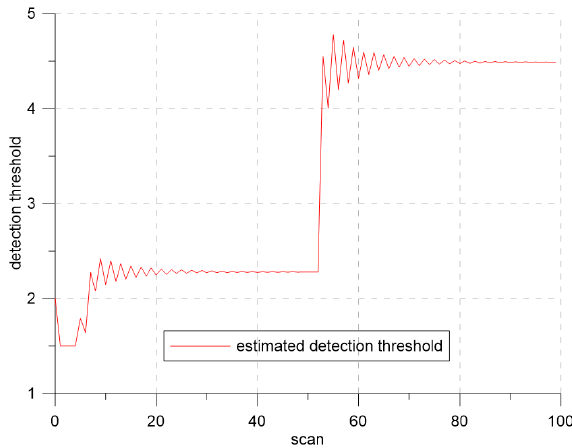
Figure 19. The detection threshold for Scenario